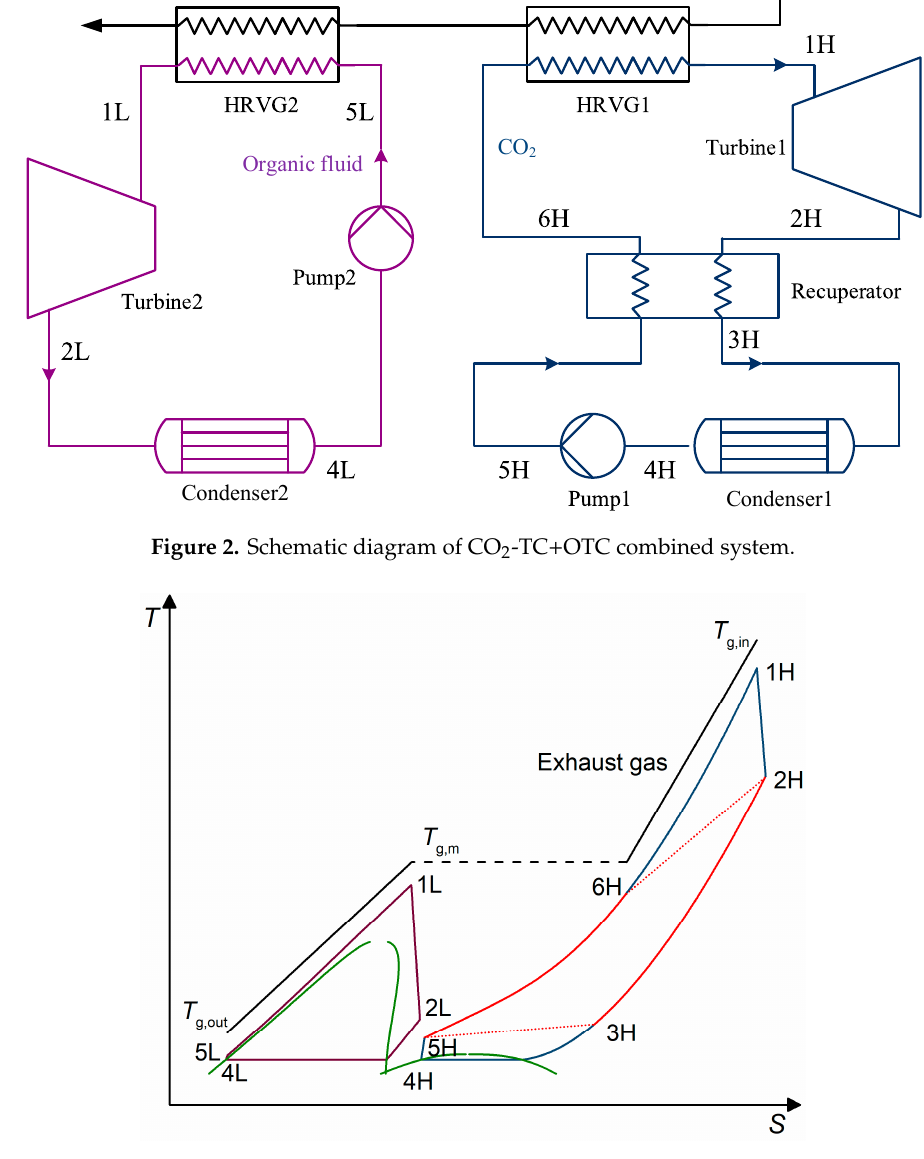
Figure 3. T-s diagram of CO 2 -TC + OTC combined system.